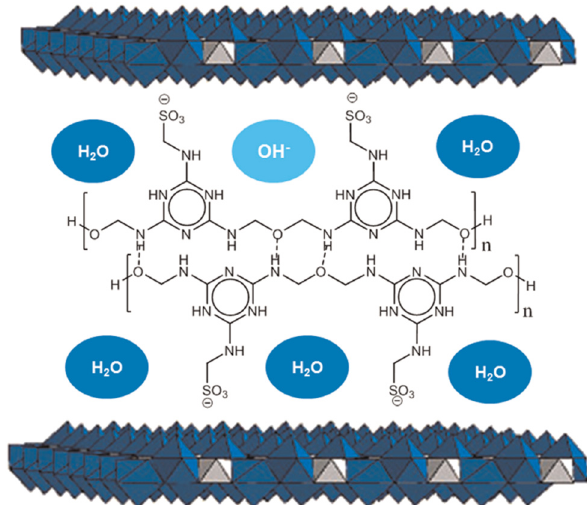
Figure 18: Schematic representation of sulfonated melamine for - maldehyde intercalation compound, reprinted with permission from ref. [ 127 ] ; Copyright: 2015, Elsevier.